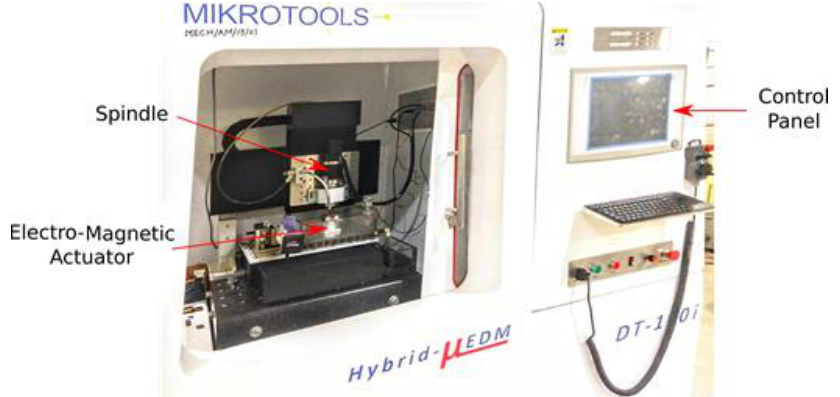
Figure 2. Micro-EDM machine used for experimentation.